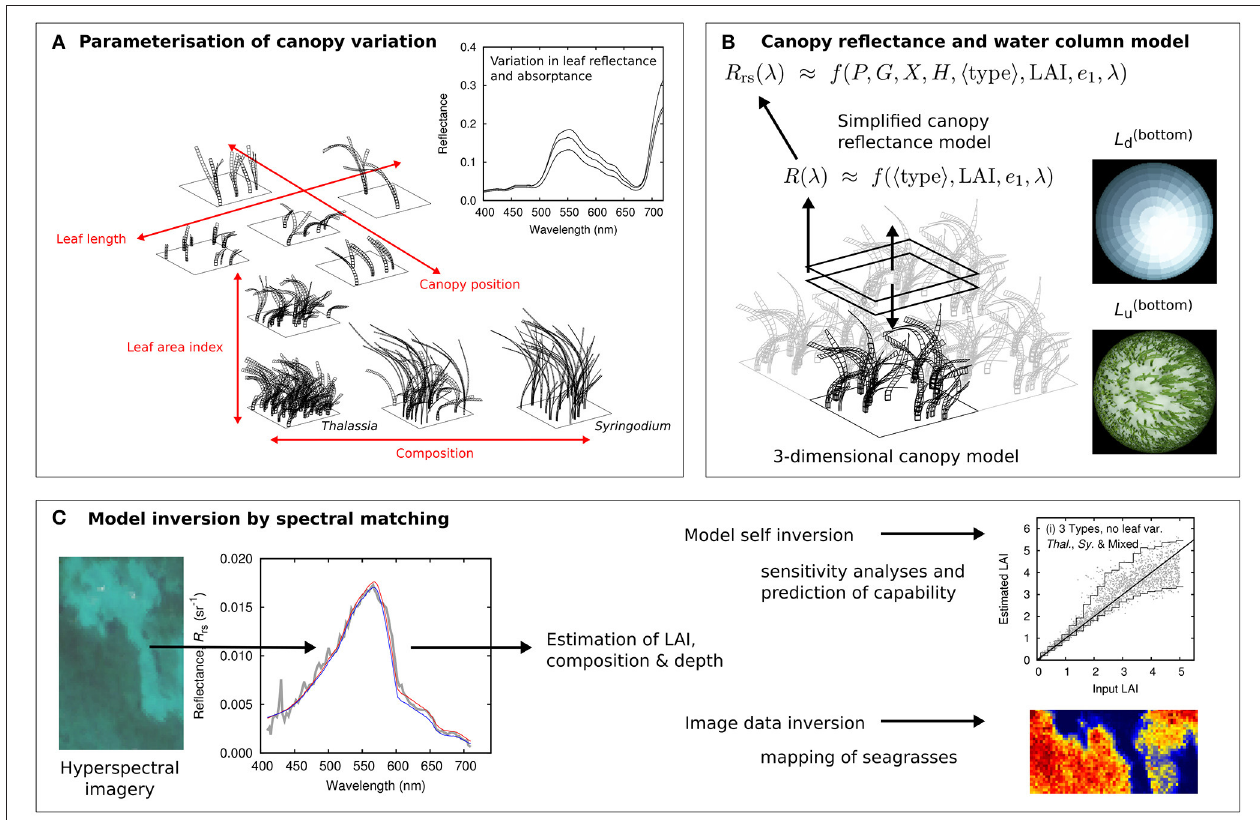
FIGURE 1 | Overview of seagrass reflectance model and analysis. (A) Canopies are parameterized by four factors: Composition, leaf area index (LAI), leaf lengths, and leaf position. (B) A three dimensional canopy model estimates the top of canopy reflectance over all conditions and the results are reduced to a simpler functional form that includes the water column. (C) A spectral matching procedure applies the simplified model in sensitivity analyses and image processing.